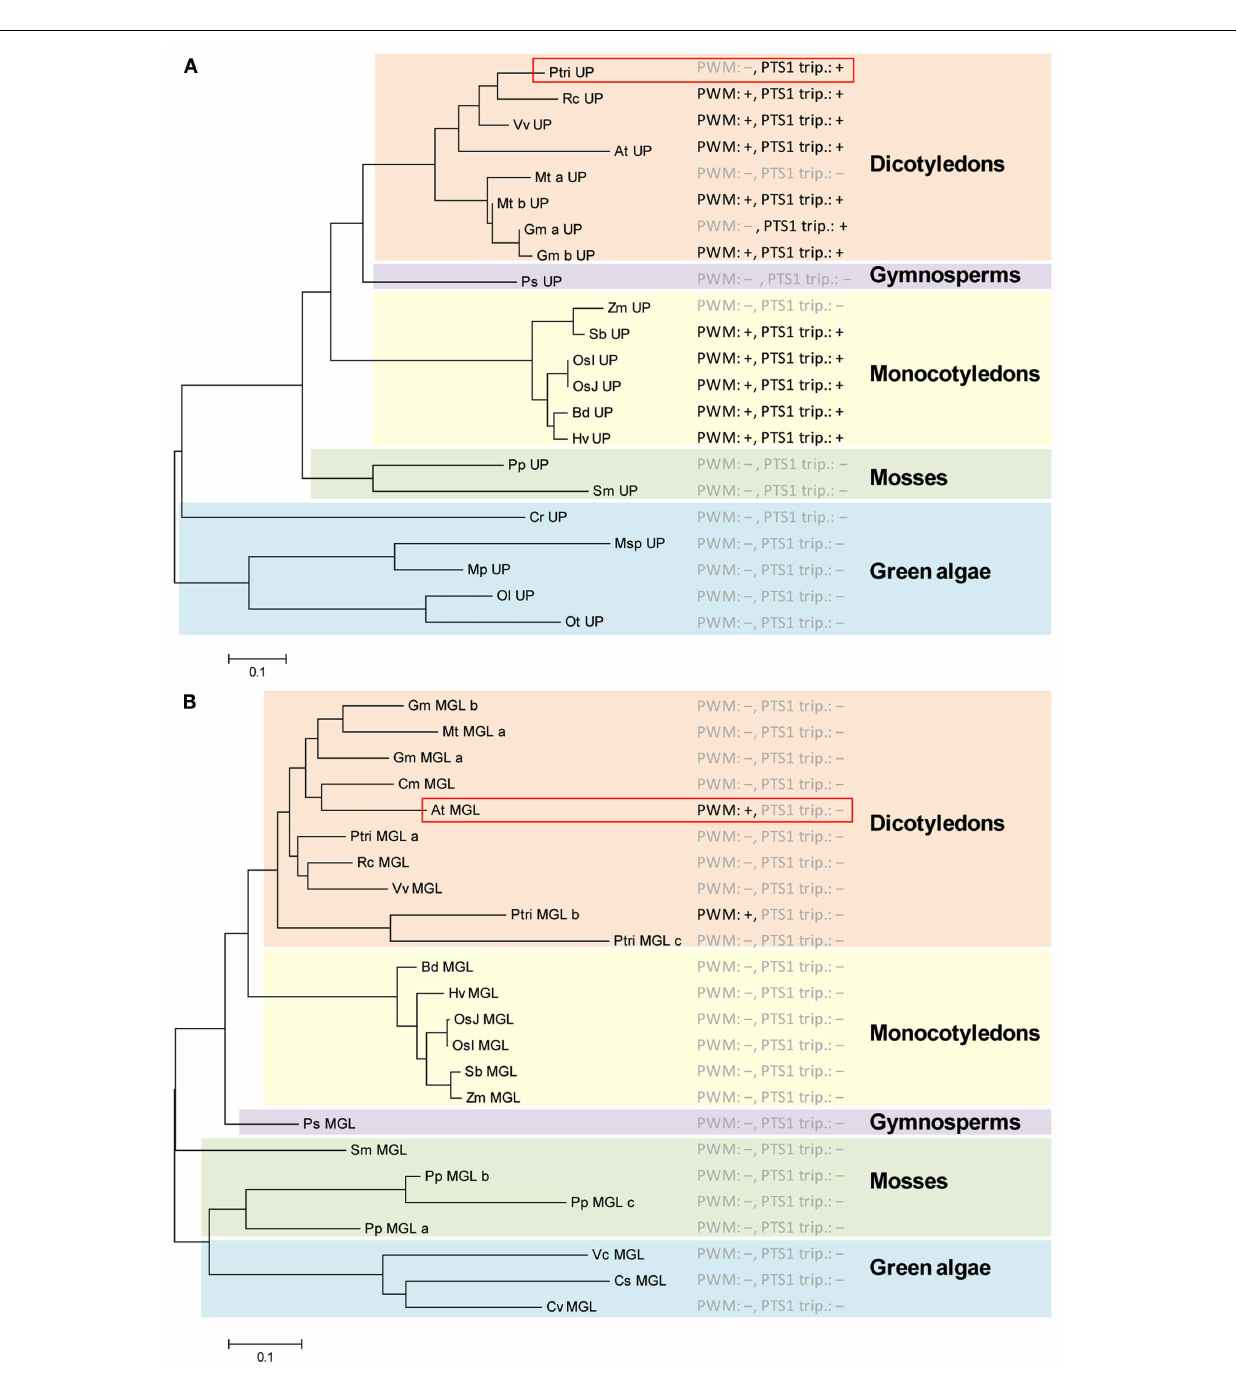
FIGURE 3 |Analysis of predicted PTS1 conservation in putative orthologs of ambiguously predicted plant PTS1 proteins by a combination of phylogenetic and PTS1 prediction analysis. Two ambiguously predicted, putative PTS1 proteins from P. trichocarpa (XP_002313892) (A) and Arabidopsis thaliana (NP_176647) (B) were blasted against the non-redundant protein database of GenBank. Putatively orthologous proteins (including in-paralogs) were identified in spermatophyta including eudicotyledons (e.g., Arabidopsis , Ricinus ), monocotyledons ( Liliopsida , Oryza , Zea ), and gymnosperms ( Coniferopsida , Picea ), in mosses ( Lyciopodiophyta , Selaginella ;